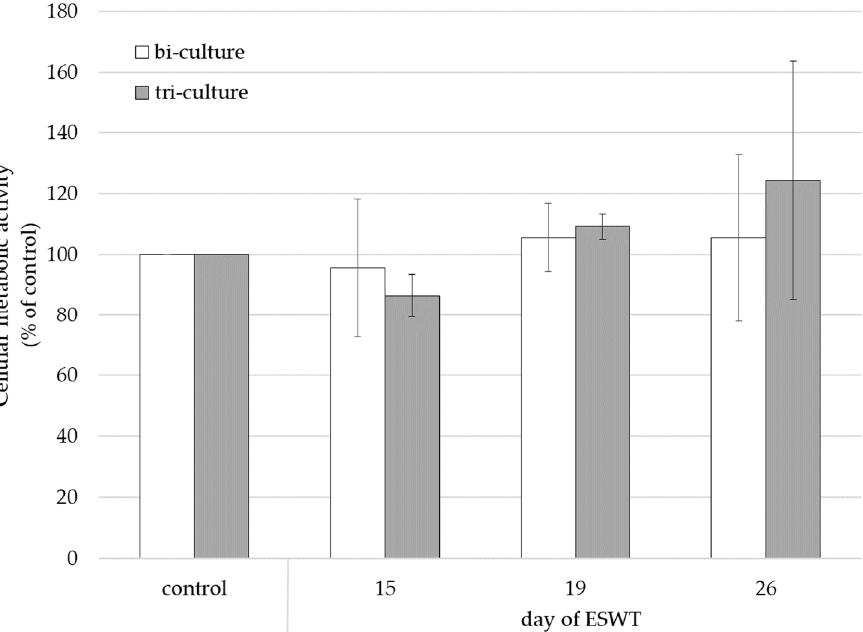
Figure 4. Cellular metabolic activity of bi-cultures of endothelial cells and fibroblasts or tri-cultures of endothelial cells, fibroblasts, and epithelial cells on collagen matrices two days after ESWT on day 15, day 19, or day 26 of cultivation. Untreated bi- and tri-cultures served as control. Cellular metabolic activity was examined by AlamarBlue TM cell viability assay. Data are expressed as means ± SD. Measurements were conducted in duplicate and repeated three times.